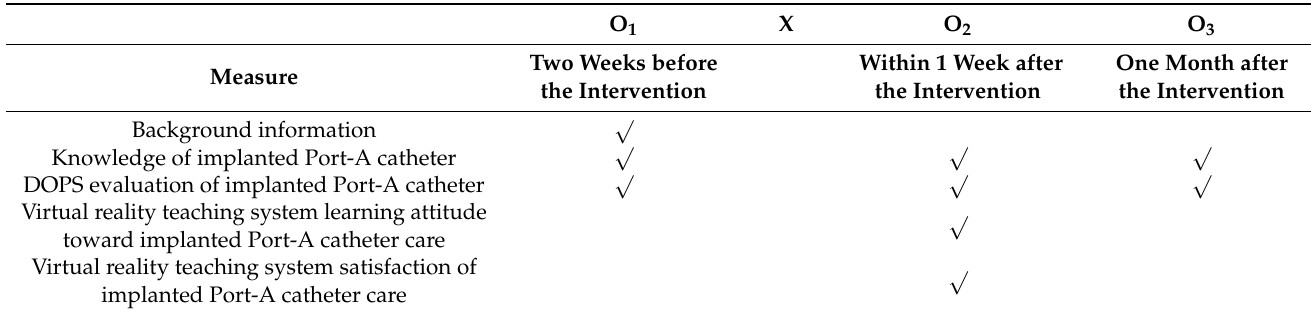
Table 1. Study design and